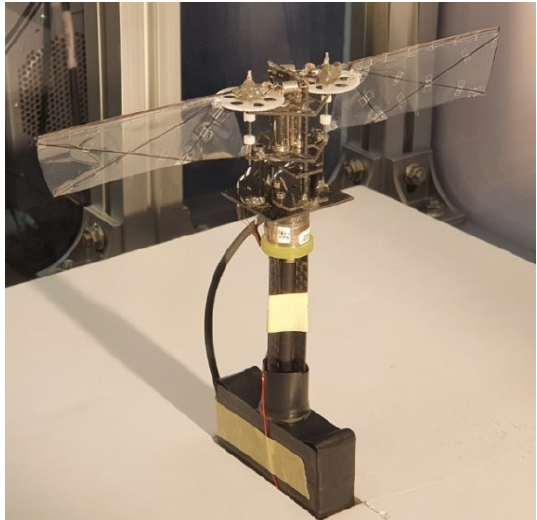
Figure 9. Experimental setup for measuring torques and lift forces with roll, pitch, and yaw control inputs.